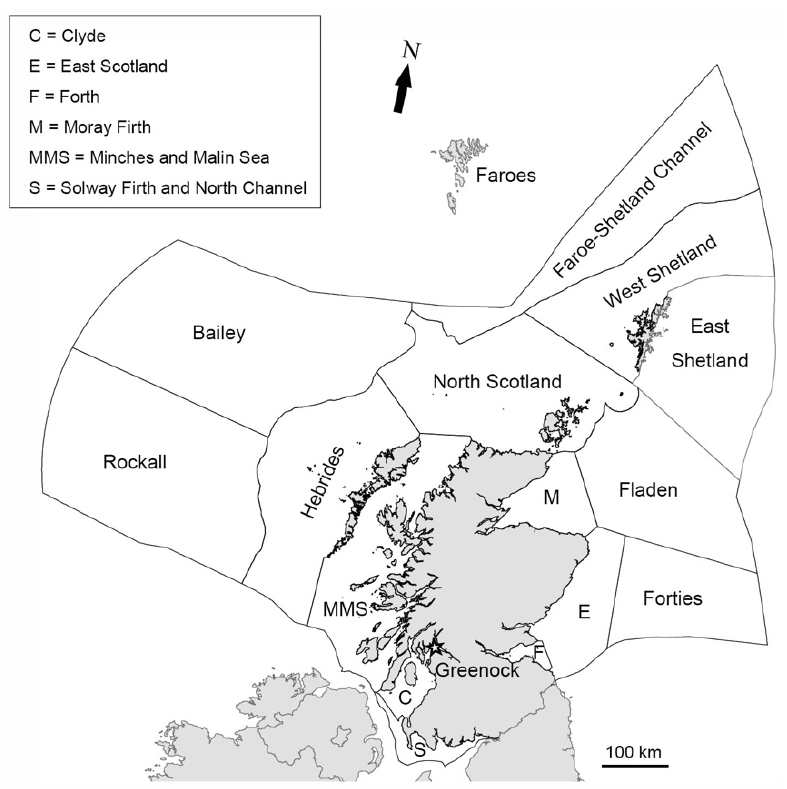
Figure 1. Regions of the sea around Scotland, based on work by Rouse and others [9], and the location (star) of the latest Pleistocene fossil bryozoan locality at Garvel Park, Greenock.